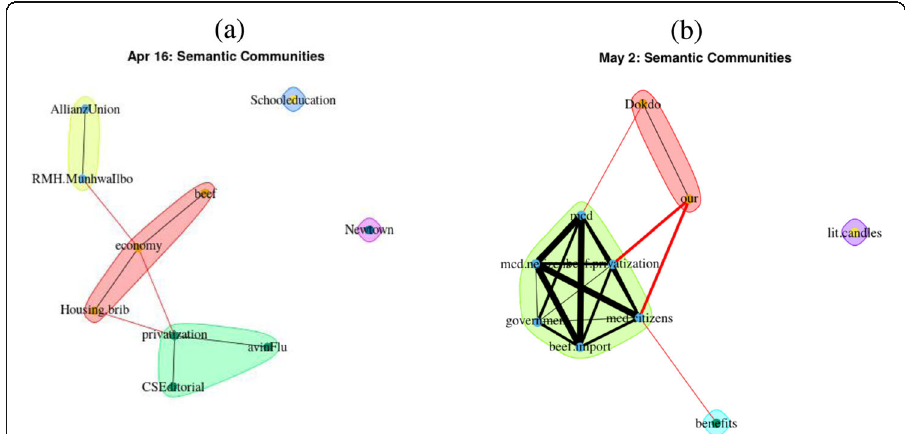
Fig. 1 Note: Topic Networks of April 16 and May 2. Note : a represents the network of topics from April 16 using the top 15 terms, and b for May 2. Color bubbles indicate semantic communities, where black and red lines respectively indicate intracommunity and inter-community